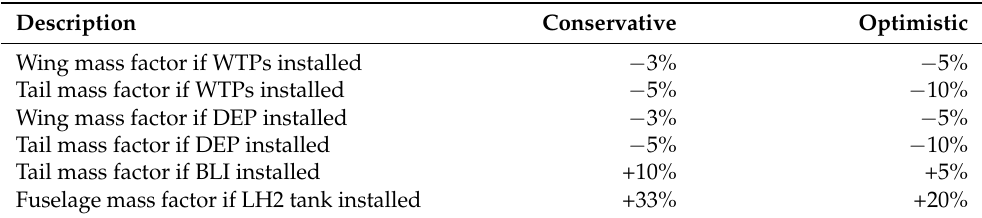
Table 5. Factors for structural mass